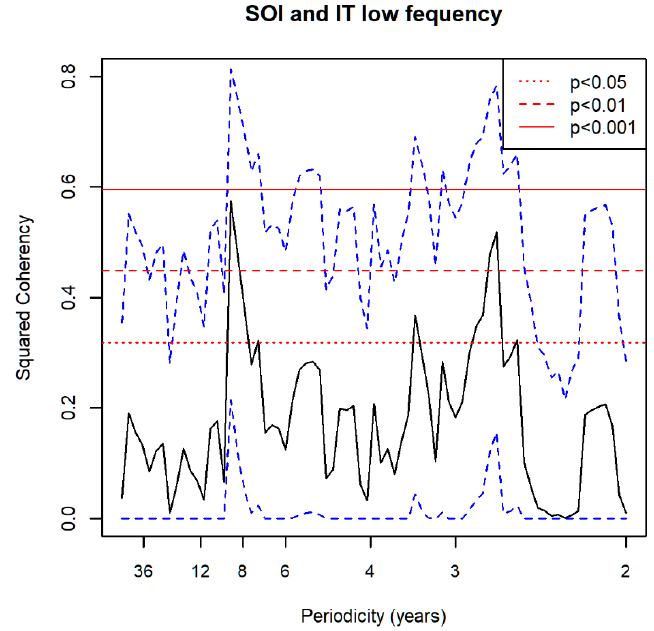
Figure 10. Squared coherency of SOI and ITlf. The solid horizontal red line indicates significance at p = 0.001, dashed line p = 0.05, dotted line p = 0.05. The blue dotted lines represent 95% confidence intervals.